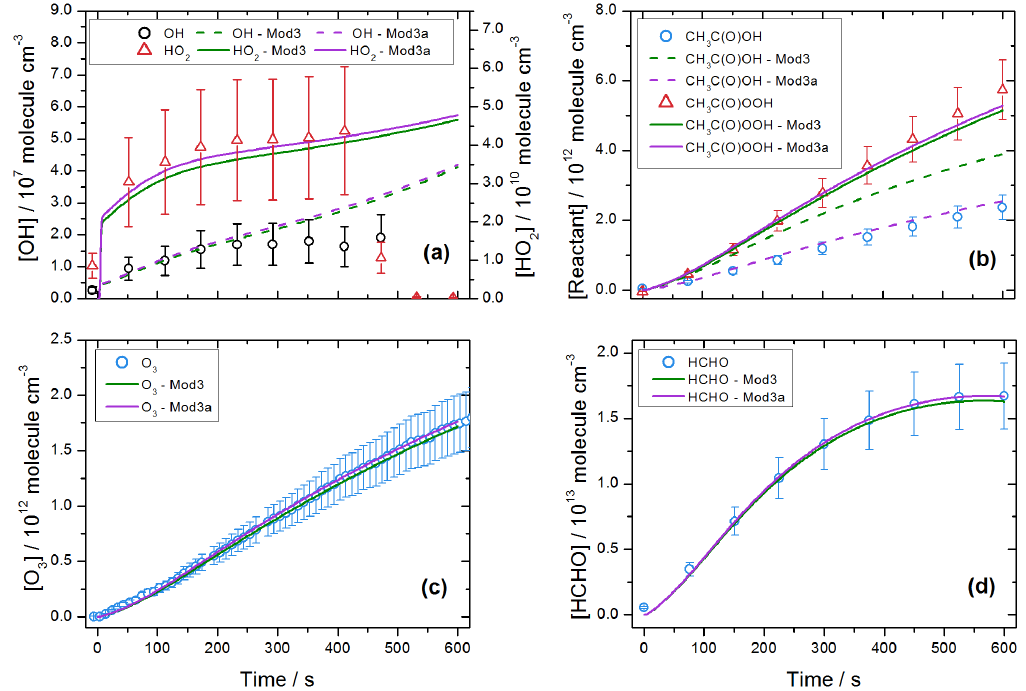
Figure 7. Experimental results for OH and HO 2 (a) , CH 3 C(O)OOH and CH 3 C(O)OH (b) , O 3 (c) and HCHO (d) , as a function of time for experiment P9 where [CH 3 OH] 0 :[CH 3 CHO] 0 = 0.0, 1000mbar and 293K. Yields for Reaction (R5) were modelled using the base model reaction scheme shown in Table 2 and varied to fit the measurements, using k (R5) = (2.4 ± 0.4) × 10 − 11 cm 3 molecule − 1 s − 1 and α (R5a) = 0.42 ± 0.05, α (R5b) = 0.14 ± 0.04 and α (R5c) = 0.44 ± 0.10 (Model 3). Model agreement to measured CH 3 C(O)OH was improved by varying the modelled branching ratios of Reactions (R20a) and (R20b) are shown in trace Model 3a. All uncertainties quoted to ± 2 σ .